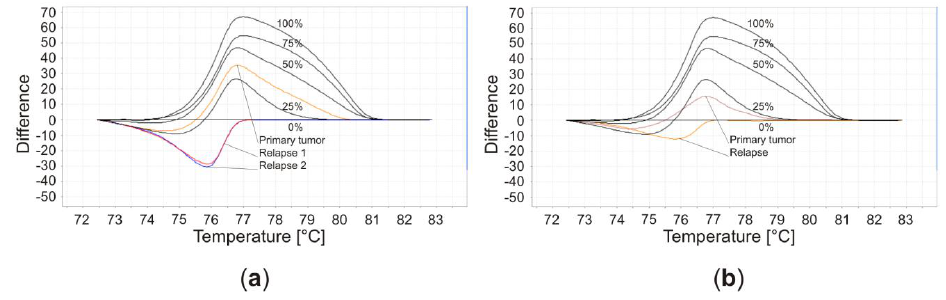
Figure 1. Example of two patients (patient 3 and 7) with a change in O 6 -methylguanine-DNA methyltransferase (MGMT) methylation status as determined by high-resolution melting PCR (HRM). Shown are the melting curves. The methodology has been described in detail elsewhere [37] and is highly accurate compared to methylation-specific PCR (MSP) [55]. ( a ) Patient 3 had a glioblastoma multiforme (GBM) which was methylated between 25% and 50%, while his two relapses were unmethylated. ( b ) Patient 7’s GBM had MGMT promoter methylation between 10% and 25%. His relapse was unmethylated. Patients’ details are summarized in Table 1.